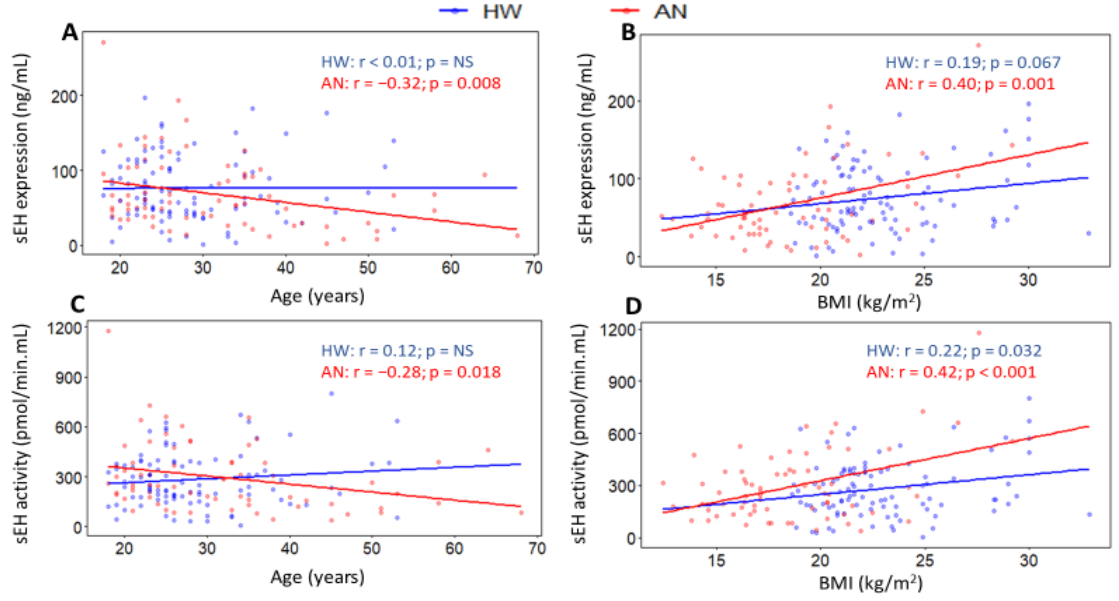
Figure 5. Scatterplots for Pearson’s correlations of ( A , B ) fasting sEH expression and ( C , D ) sEH activity with age and BMI in healthy women (blue) and women with anorexia nervosa (red). Colored dots and solid lines represent individual data points and slopes of the examined relationships, respectively. r and p indicate Pearson’s correlation coefficient and p value, respectively. HW: healthy